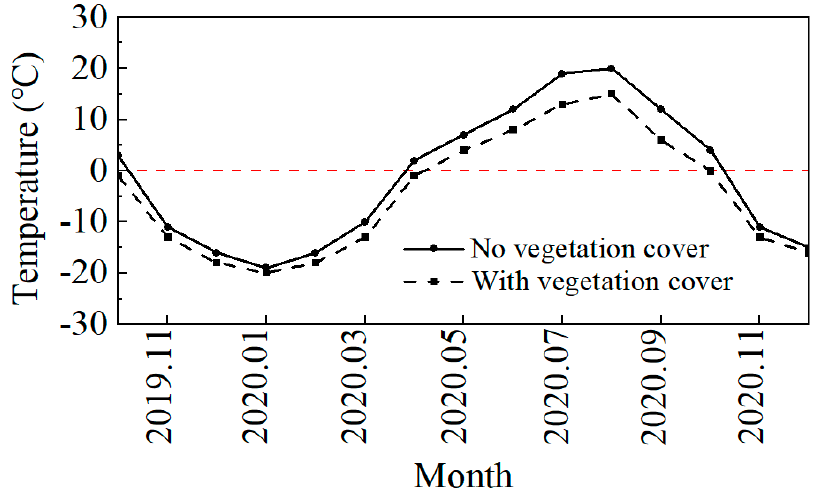
Figure 5. Monthly average land surface temperature.